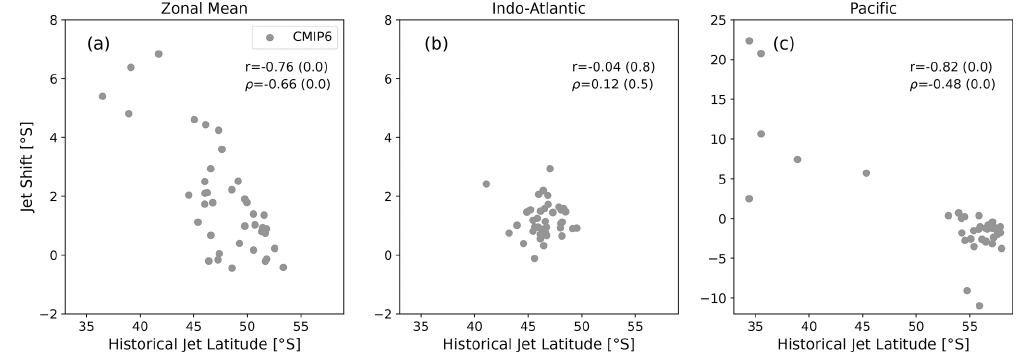
Figure 2. JJA future jet shift plotted against climatological jet latitude for the CMIP6 models. The Pearson correlation coefficient r and the Spearman rank correlation coefficient ρ are given for the CMIP6 values together with their respective p values. The zonal mean was taken